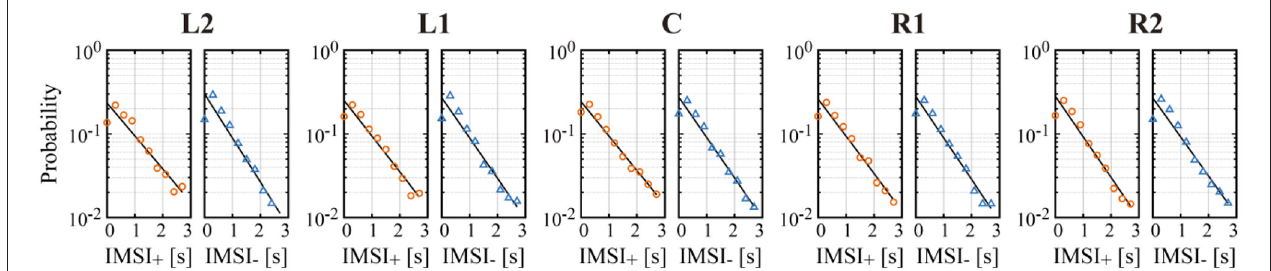
FIGURE 7 | Semi-log plot of the probability of inter-microsaccadic intervals (IMSI) of all left/right MS across all subjects, with a regression line (black line) in each condition. IMSI + plotted by the orange circles are the IMSI of rightward MS, and IMSI − plotted by the blue triangles are the IMSI of leftward MS.